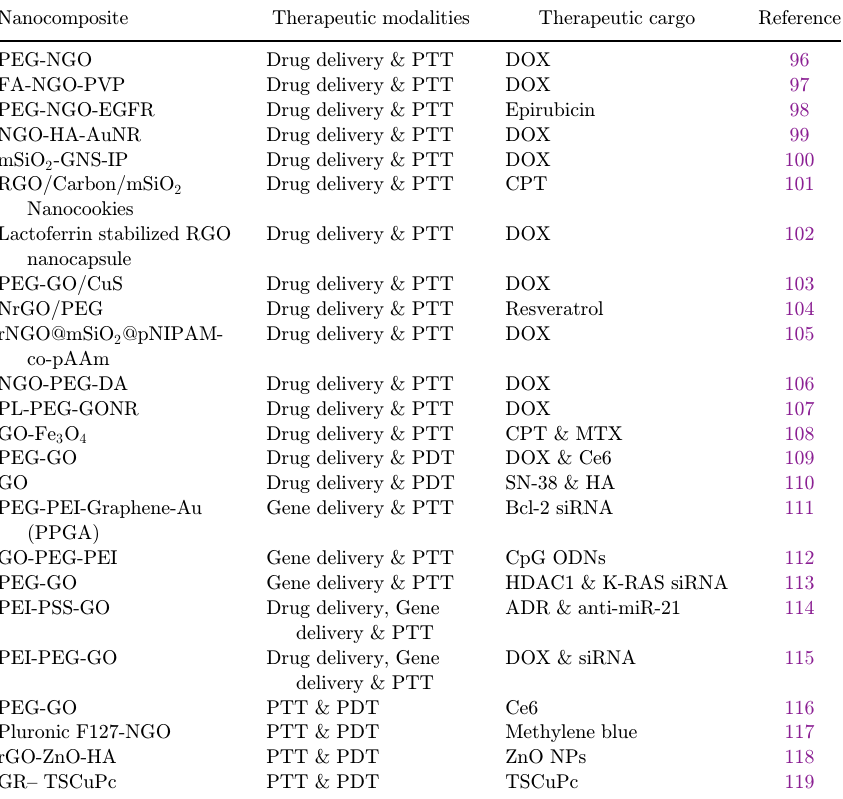
Table 4. Summary of graphene-based nanomaterials for combined therapeutic strategies.